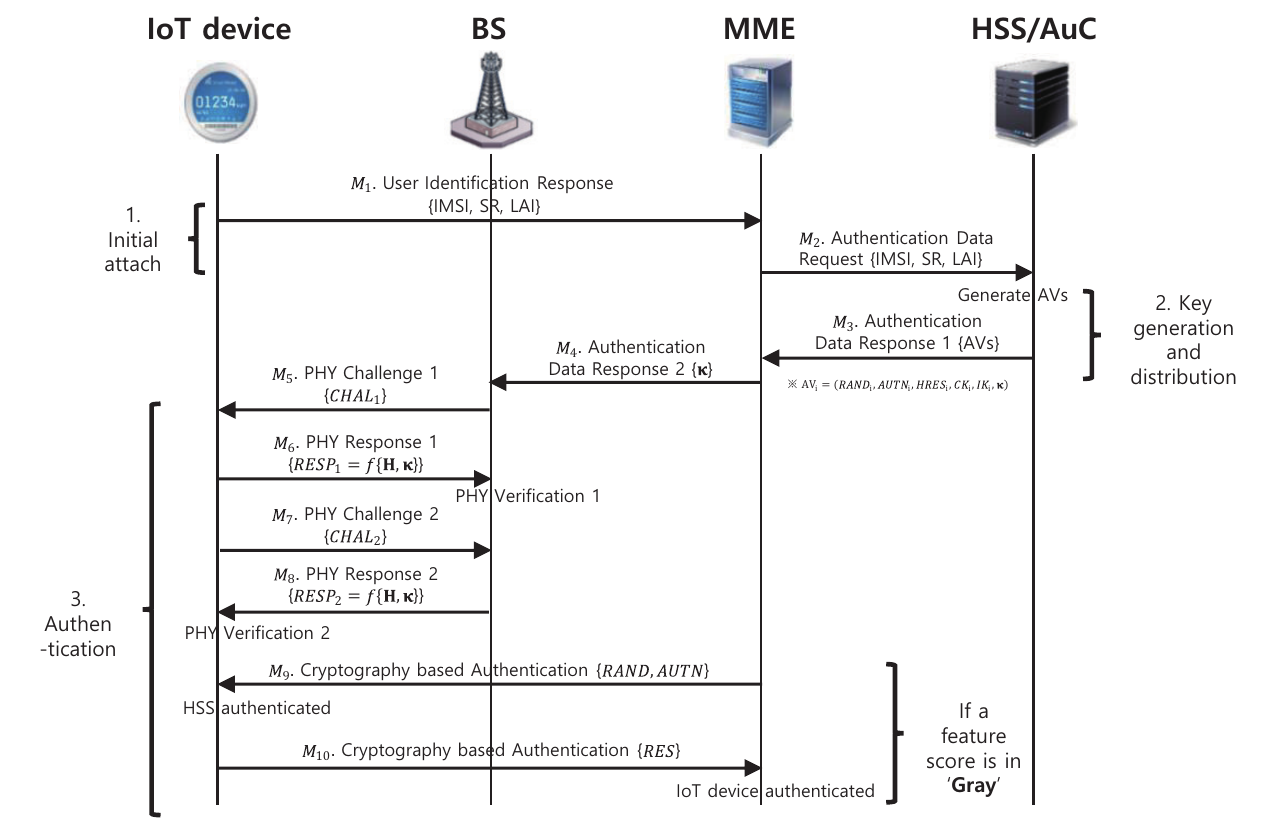
Figure 1. PL-AKA cross-layer authentication protocol